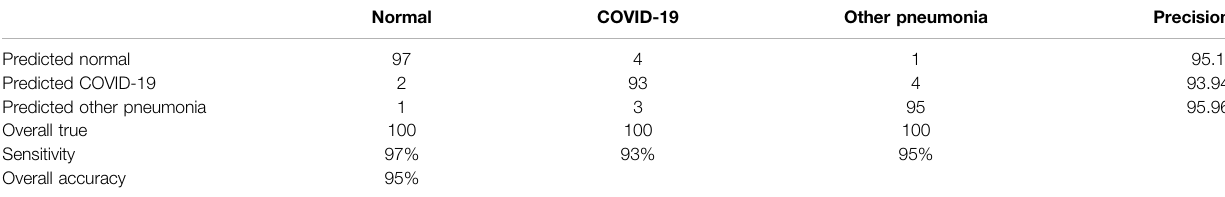
TABLE 5 | Testing results of the whole architecture.